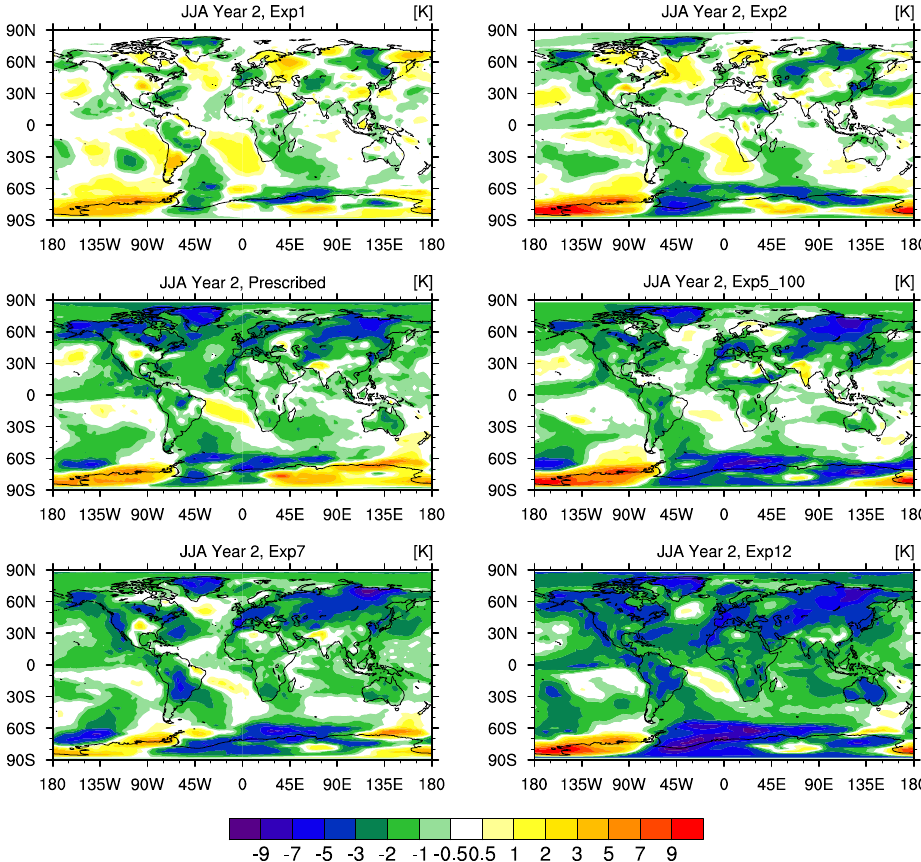
Fig. 6. Surface temperature changes [ K ] averaged for June, July, and August of the second year following the soot injection for Exp1, Exp2, Prescribed, Exp5_100, Exp7, and